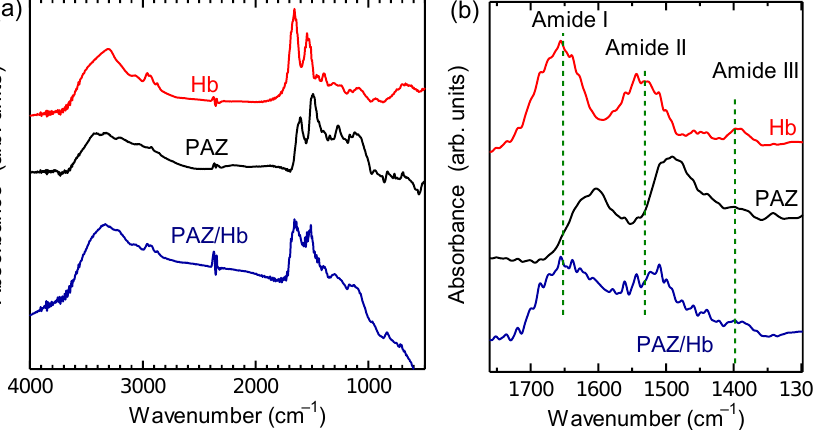
Figure 3. ( a ) Fourier-transform infrared (FT–IR) absorption spectra of hemoglobin (Hb), polyazobenzene (PAZ), and polyazobenzene/Hb (PAZ/Hb). ( b ) Magnifications of the IR absorption spectra.